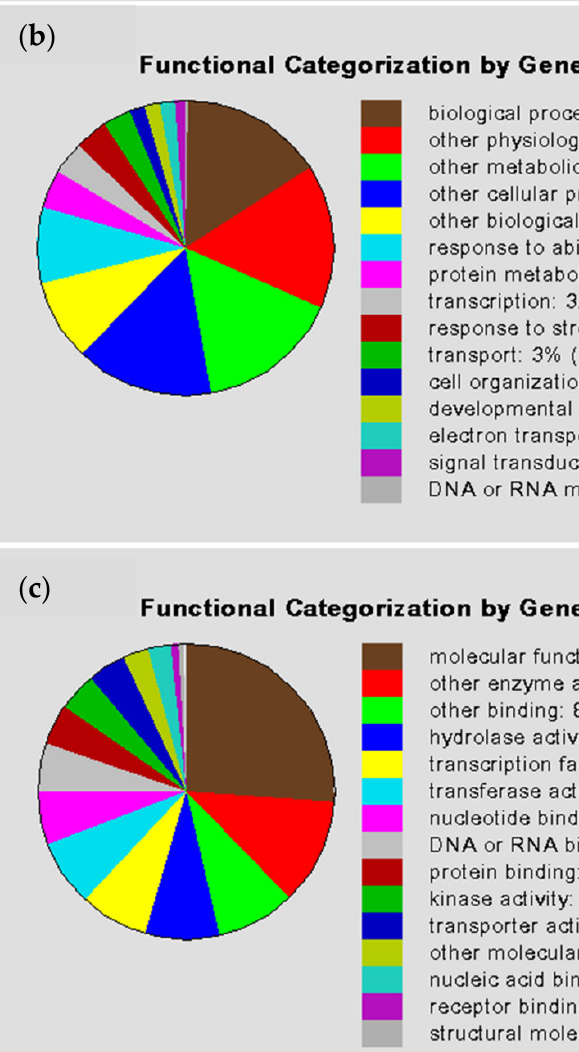
Figure 3. Pie charts for genes having GO functional annotation. The percentages were calculated with respect to the number of all redundant genes with annotation in each GO term. ( a ) GO terms of cellular component; ( b ) GO terms of biological process; ( c ) GO terms of molecular function.